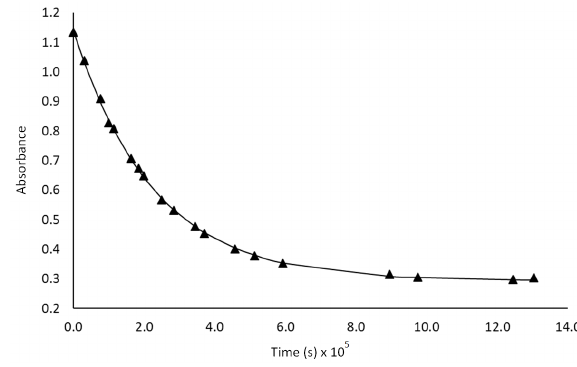
in the presence of [NaOH] Figure 5 : Alkaline hydrolysis of AMPNa 2 1.0 M at 60°C. The solid line was drawn through the calculated data points using Equation (1) with k = 4.44 × 10 -6 s -1 , E = 8466 ± 44 obs app M -1 cm -1 , and A = 0.294 ± 0.003. ∞